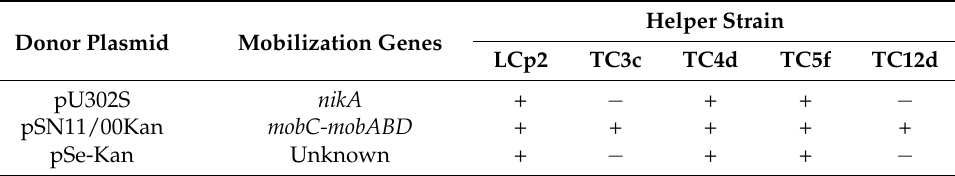
Table 3. Qualitative assessment of KanR plasmid mobilization using tri-parental agar mating. + indicates donor plasmid was mobilized, − indicates donor plasmid was not mobilized.